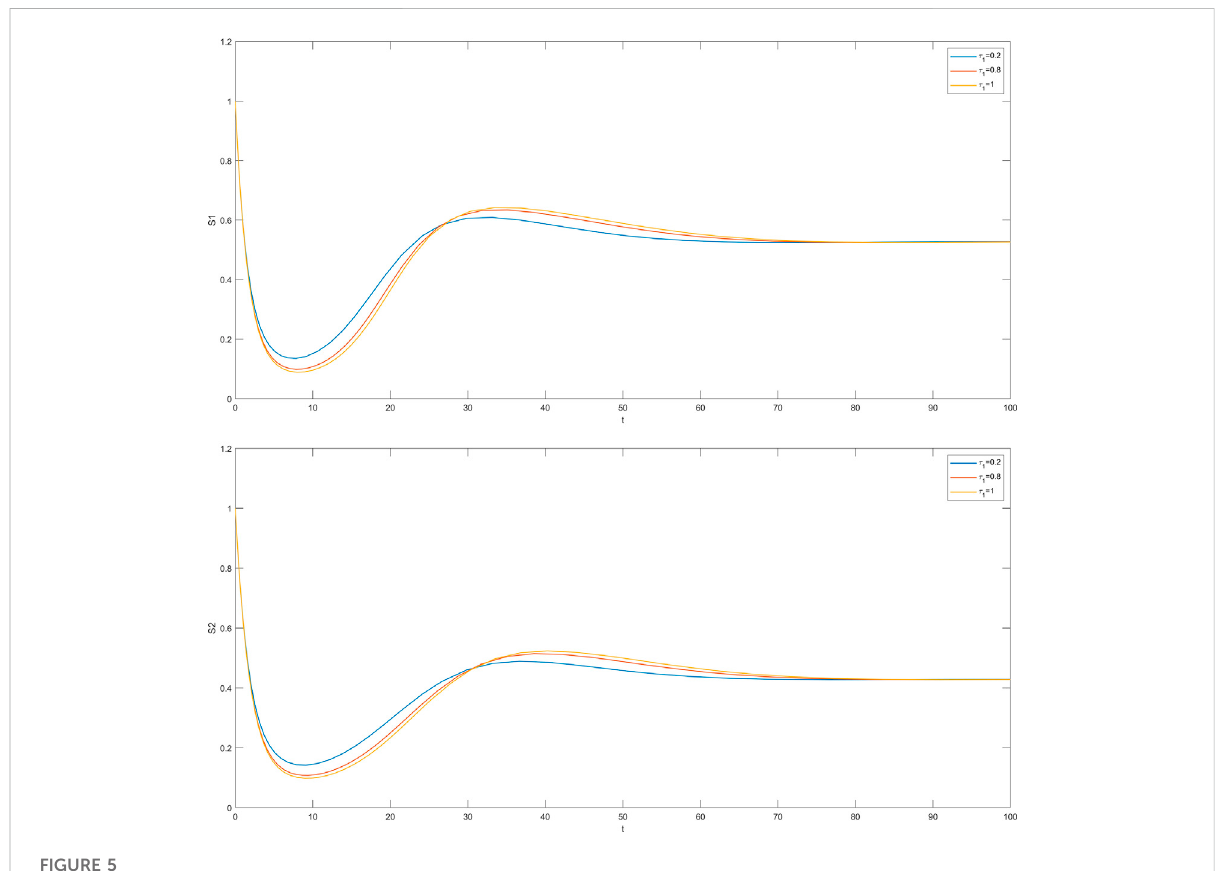
FIGURE 5 Trends of S 1 and S 2 with different time delays when R 0 >